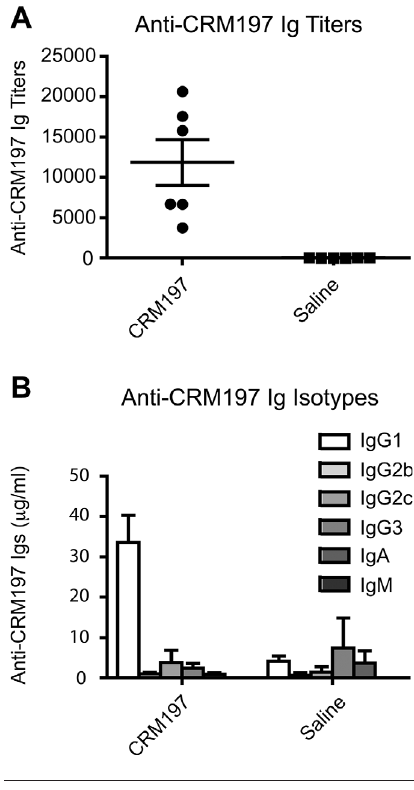
Figure 1. Anti-CRM197 antibody response in mice immunized with CRM197. (A) Specific anti-CRM197 Ig titers and (B) Ig isotype concentration (IgG1, IgG2b, IgG2c,